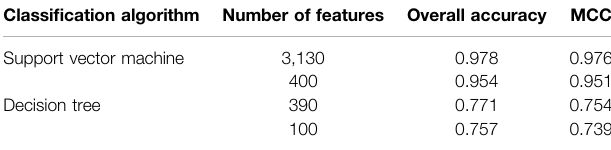
TABLE 2 | Performance of some key classi fi